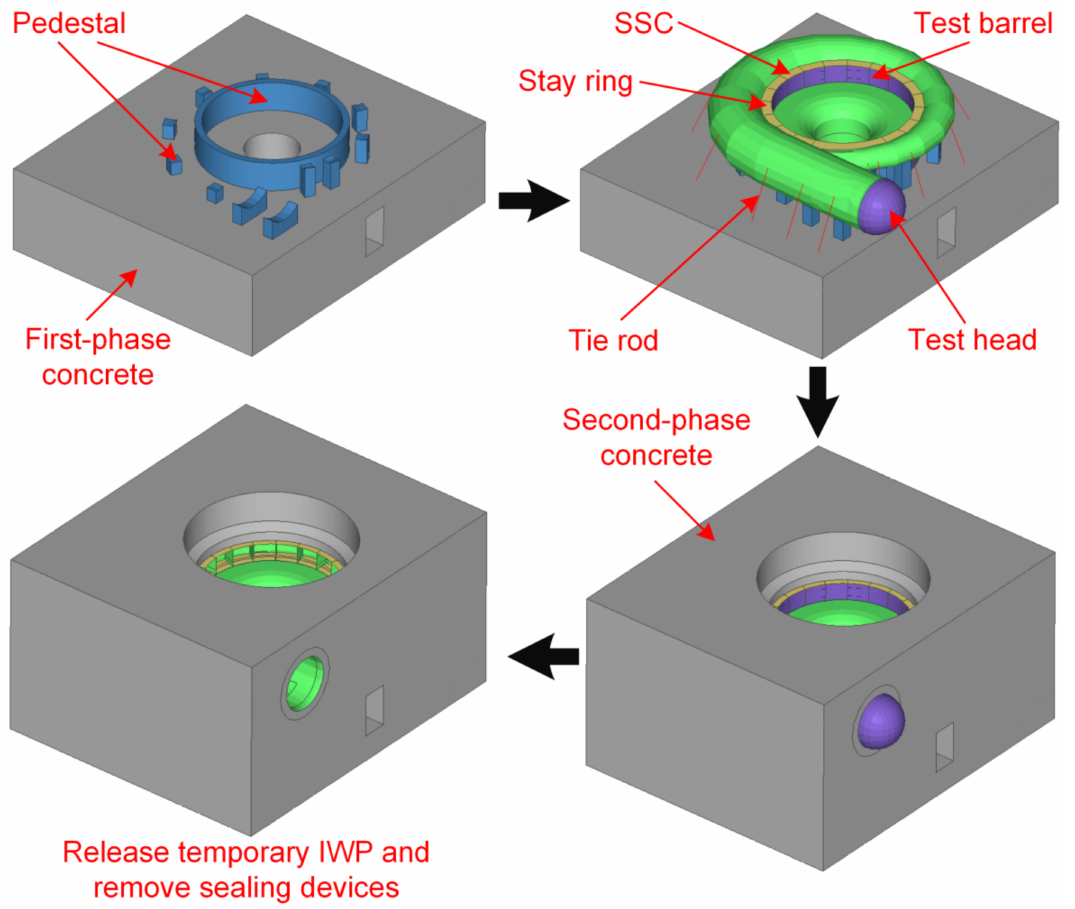
Figure 1. Standard construction procedure of P-type